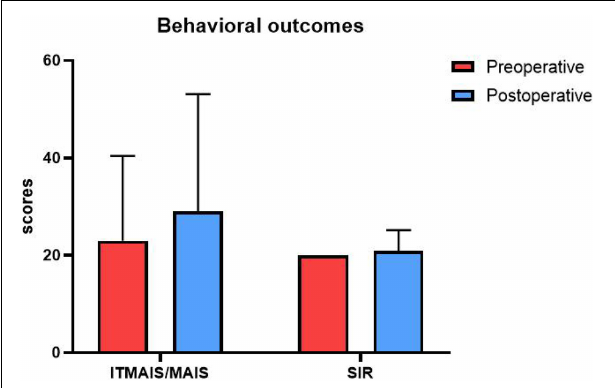
FIGURE 3 | Behavioral outcomes. The vertical axis is the score, and the horizontal axis is the test type. Red represents the preoperative test score, and blue represents the postoperative test score. The scores of the two tests did not differ significantly between the two periods.